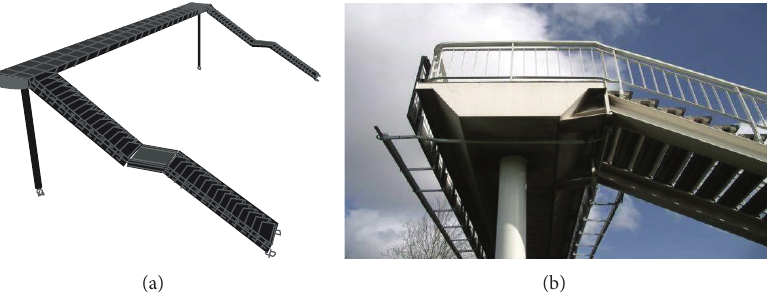
Figure 11: Steel box-girder structure under study: (a) analytical model; (b) view of column, deck, and stairway.